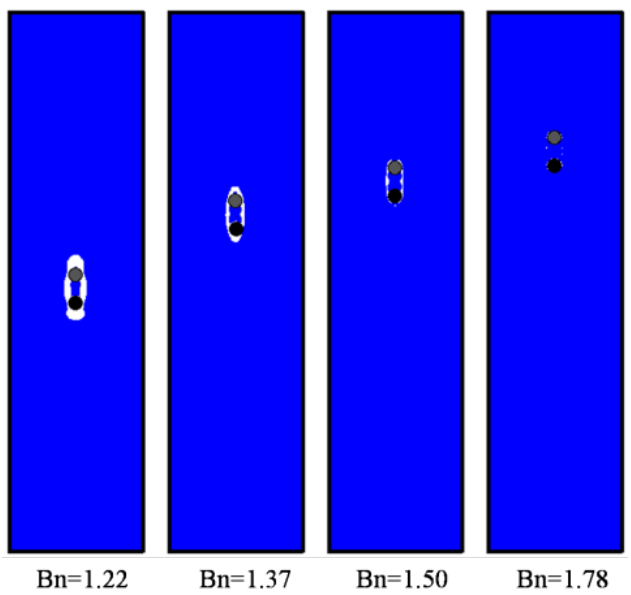
Figure 6. Snapshots at 20,000 time steps of two circular particles’ sedimentation in Bingham fluid with various Bn s (Yielded region: white; Unyielded region: blue).